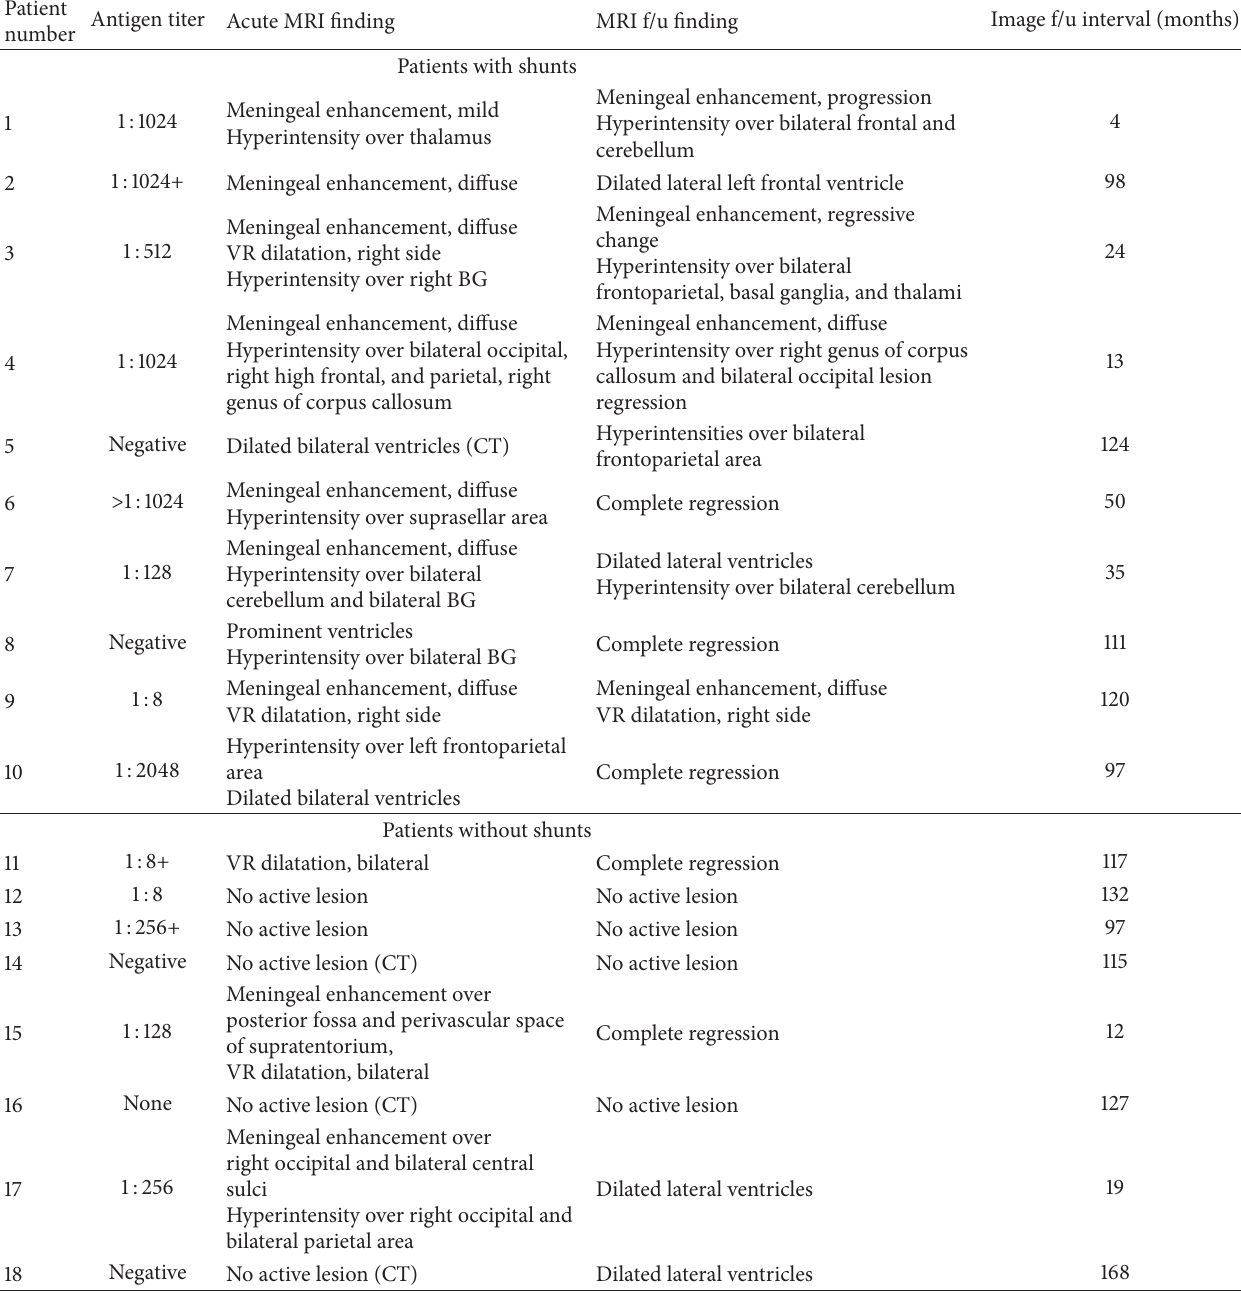
Table 2: Neuroimaging findings of the patients in the acute stage and at